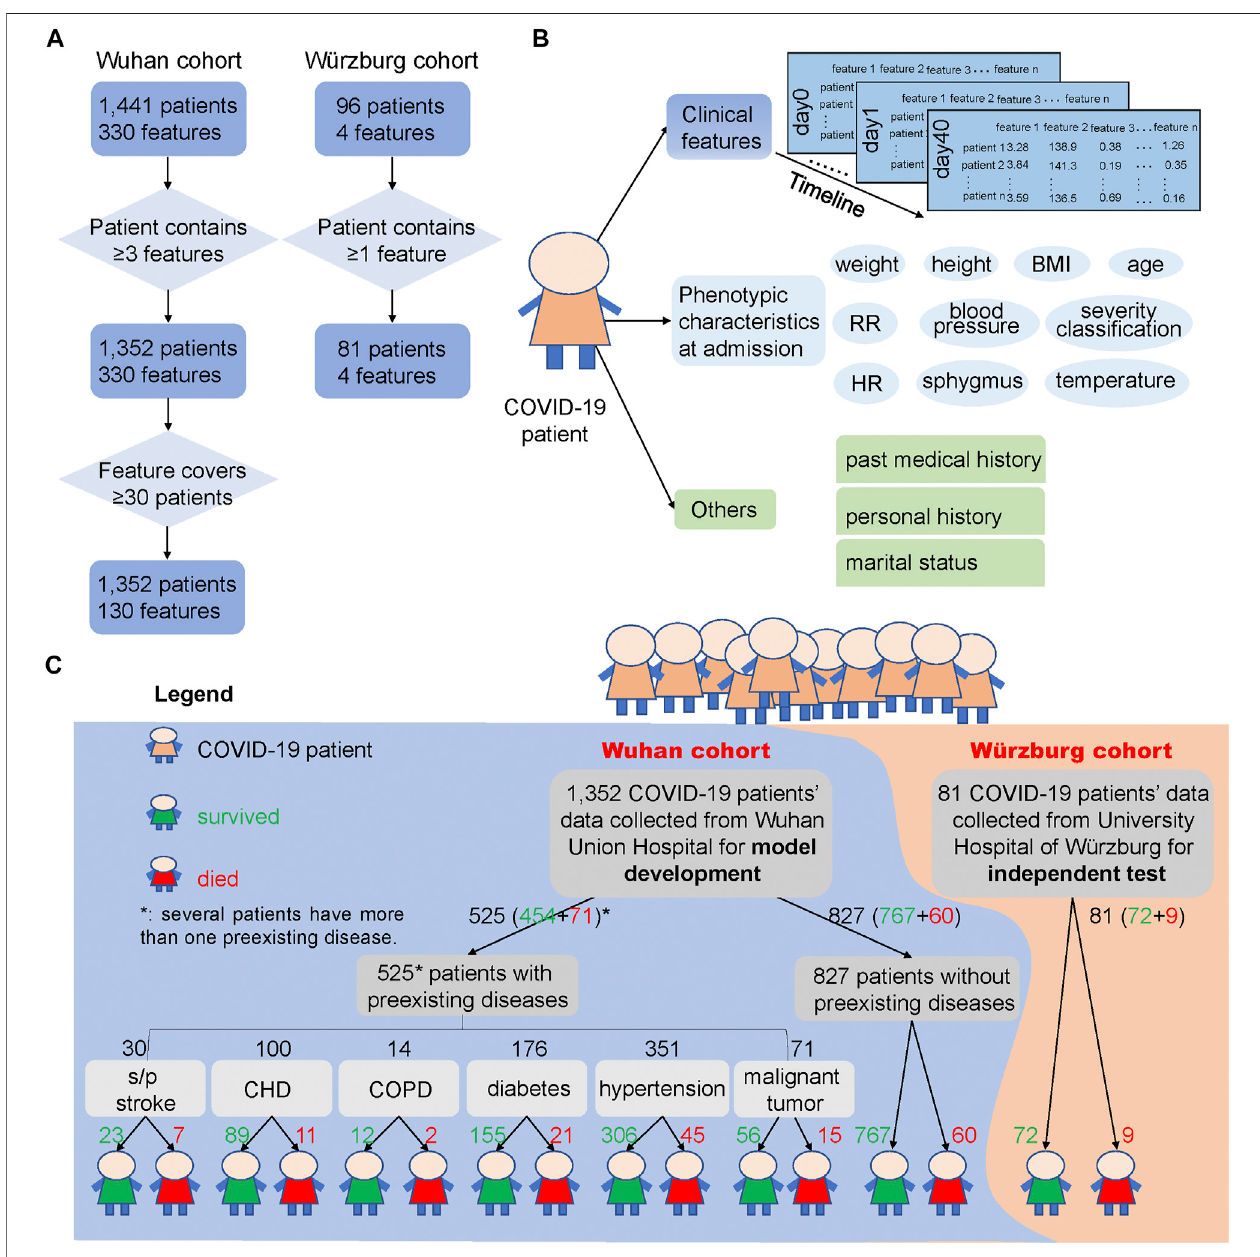
FIGURE1| COVID-19 patients andtheir clinicalfeature fi lteringprocess, phenotypiccharacteristicsand clinicalfeatures usedinthisstudy, andtheoutcome ofthe twocohorts. (A) Processof fi lteringlow-qualitysamplesofthetwocohorts.Here,330featuresintheWuhancohortweretheunionof1,441patients ’ clinicalfeaturesand 130 features were the union of the 1,352 patients ’ clinical features after fi ltering. “ ≥ 3 features ” says that the patients from the Wuhan cohort should contain at least three clinical features during the hospital stays, and “ ≥ 30 patients ” says that the clinical features that collected from clinical laboratory should cover at least 30 patients and thus could be used for subsequent analysis. In the Würzburg cohort, “ ≥ 1 feature ” says that the patient should contain at least one of the features from these four clinicalfeatures:lymphocyte(%),neutrophilcount,LDH,andCRP. (B) Differenttypesofclinicalfeaturesandphenotypiccharacteristicsusedinthetwocohorts.Weused clinical features from hospital laboratory tests for developing the prediction model, and these clinical features were also used to test the association with phenotypic characteristicsandotherrecords. (C) Overviewofsamplesusedformodeldevelopmentandindependenttest.Samplesof1,352COVID-19patientsfromWuhanUnion Hospital (Wuhan cohort, the blue background) were used for building and testing the mortality prediction model, while samples of 81 COVID-19 patients from Germany (Würzburg cohort, the orange background) were used for independent test of the mortality prediction model. The green number represents the number of patients who survived from COVID-19, while the red number means the number of patients who died from COVID-19. Note that several patients have more than one preexisting disease.